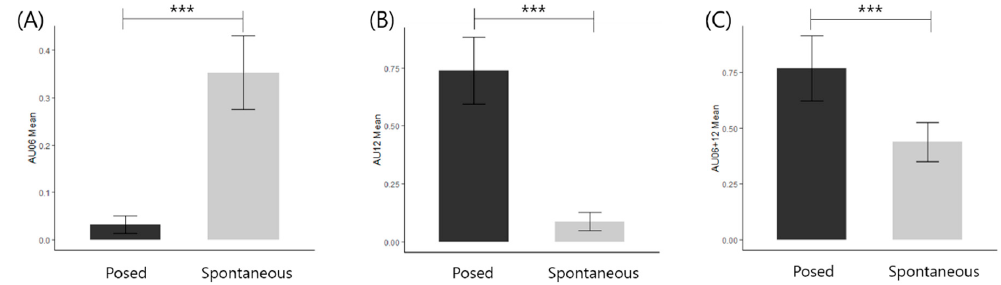
Figure 5. Contrast between posed and spontaneous smile intensities of AU. ( A ) AU06 (cheek raiser) mean score. ( B ) AU12 (lip corner puller) mean score. ( C ) AU06+AU12 mean score. (AU: Action Unit; *** P < 0.001.).